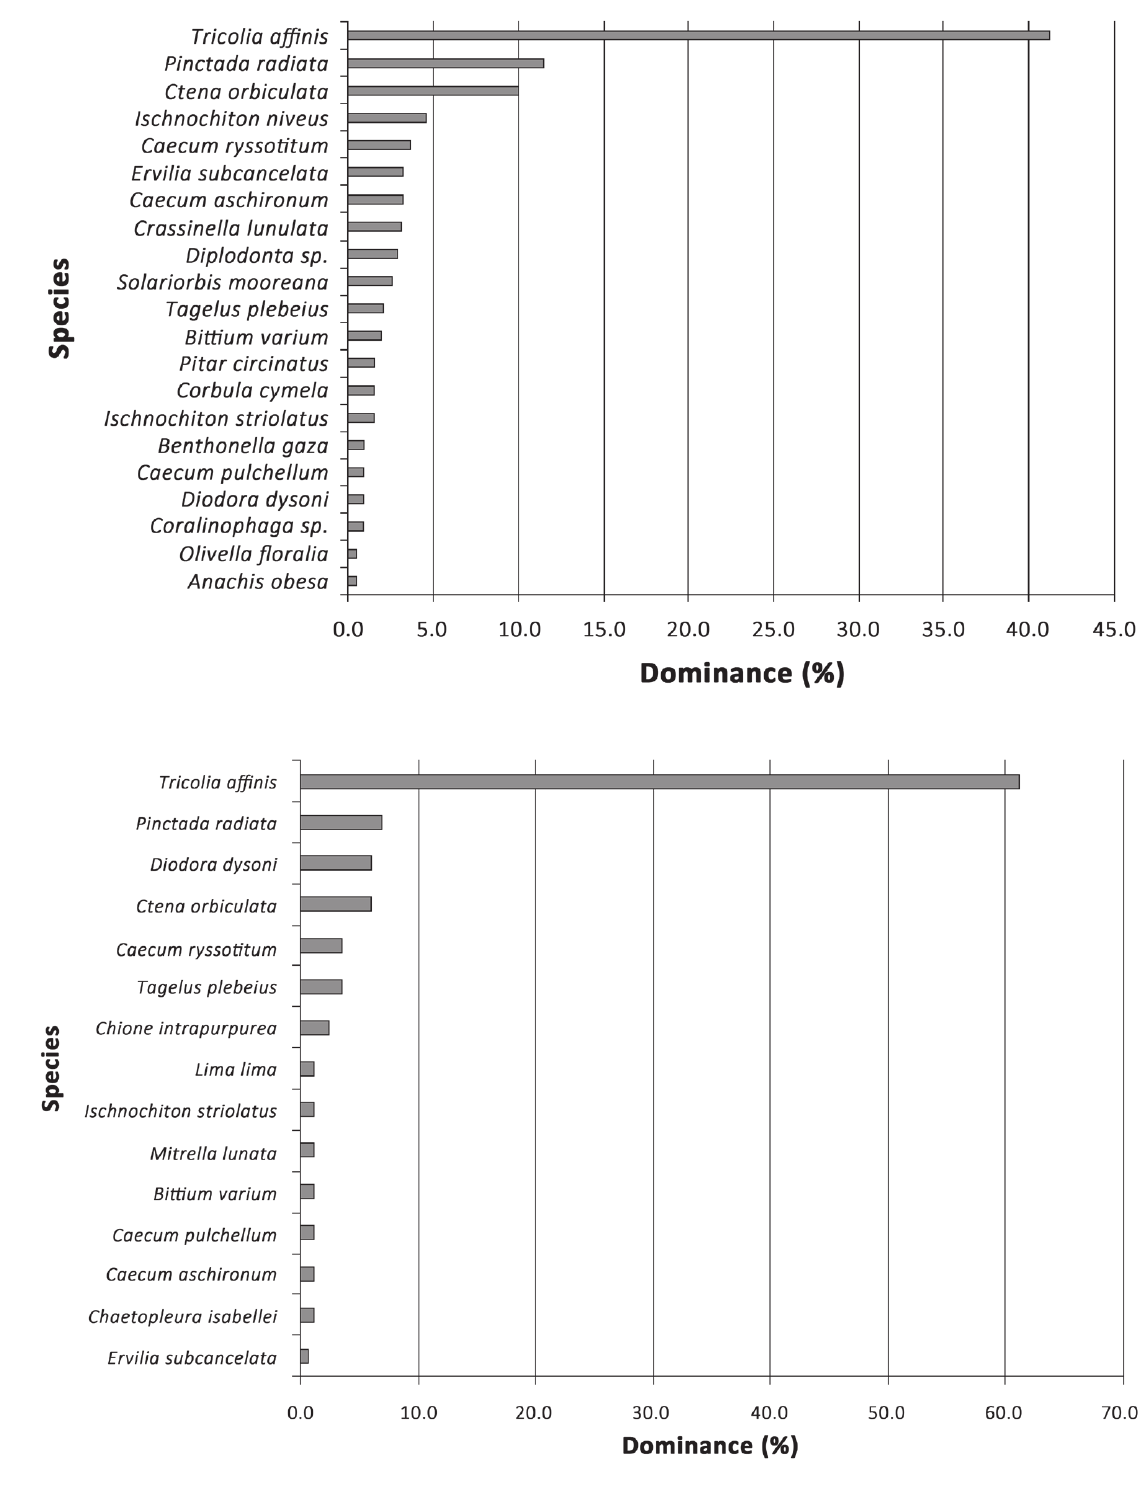
Figure 3 - Dominance of molluscan species in the belowground (a) and aboveground (b) of Halodule wrightii bed, in Goiabeiras Beach,